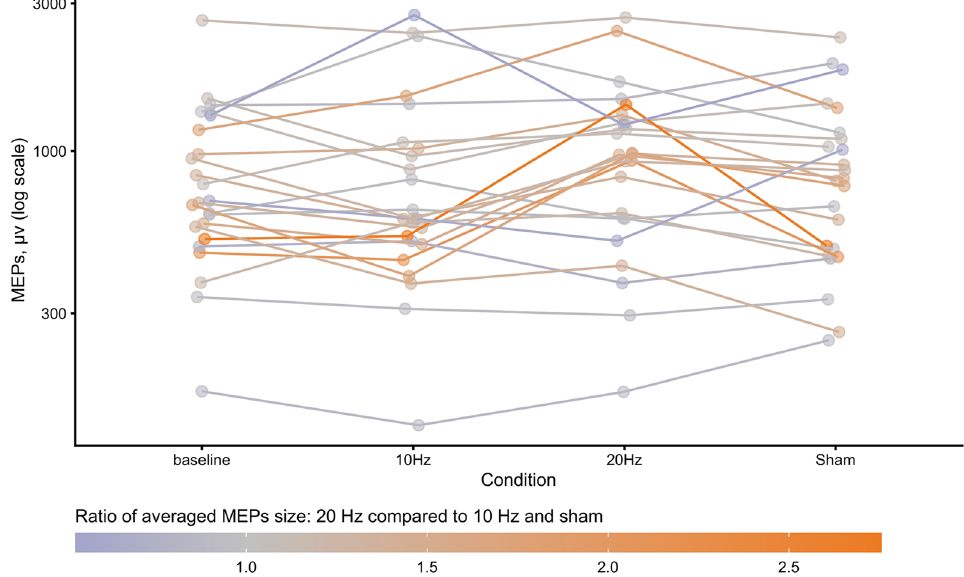
Figure 2. Individual logarithmized MEPs (in µV) measured during the baseline (averaged blocks PRE and POST) and during three tACS conditions (10 Hz, 20 Hz, sham) in Experiment 1 (online). Colors represent the ratio between individual MEPs size during 20 Hz compared to the average of individual MEPs size during 10 Hz and sham.